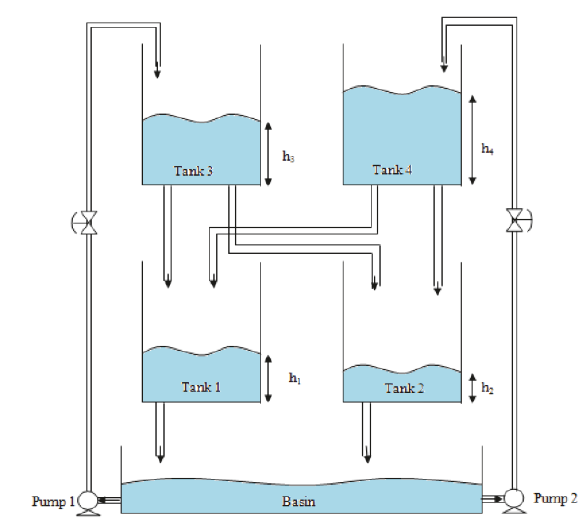
Figure 1: The quadruple tank